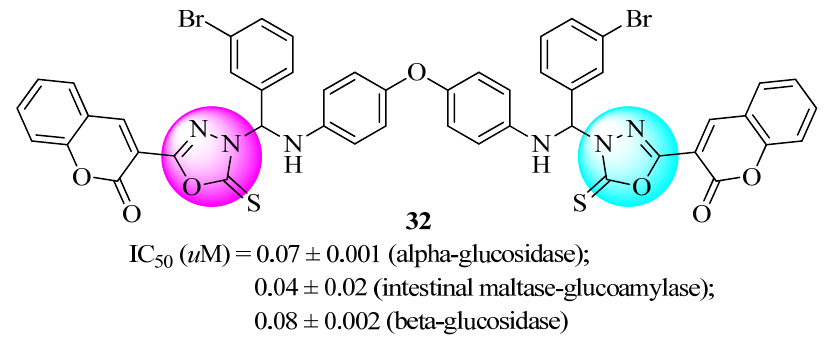
Figure 18. Anti-diabetic drugs derived from diamine-bridged coumarinyl oxadiazoles.